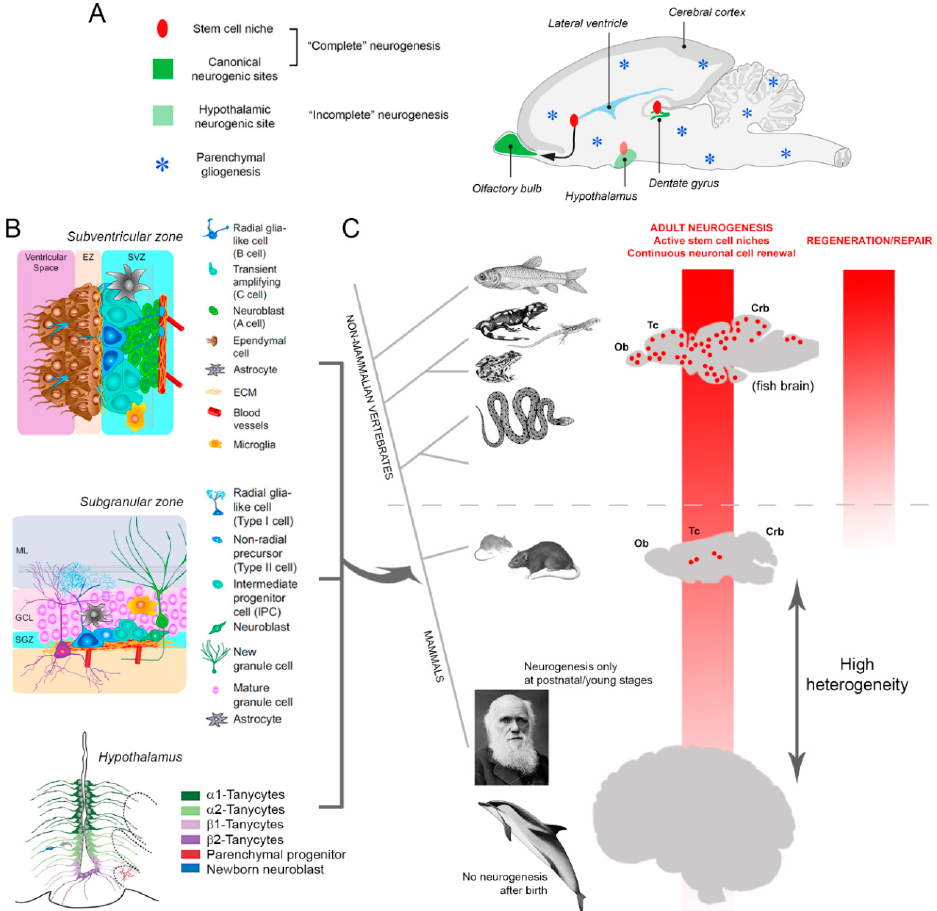
Figure 2. Adult neurogenesis in laboratory rodents and its reduction across vertebrates and